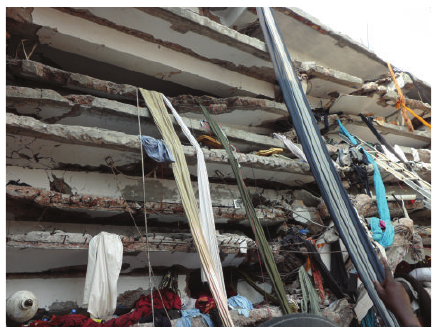
Figure 3: What happened after Rana Plaza